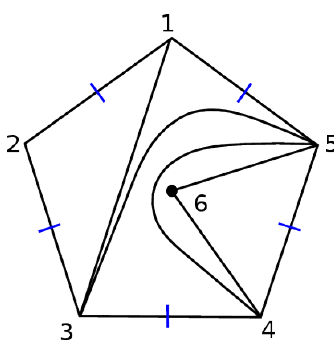
Figure 19. A triangulation in the ( A 1 ; D 5 ) Argyres-Douglas theory. There are (cid:12)ve boundary edges. The blue marks correspond to positions of (cid:12)ve Stokes